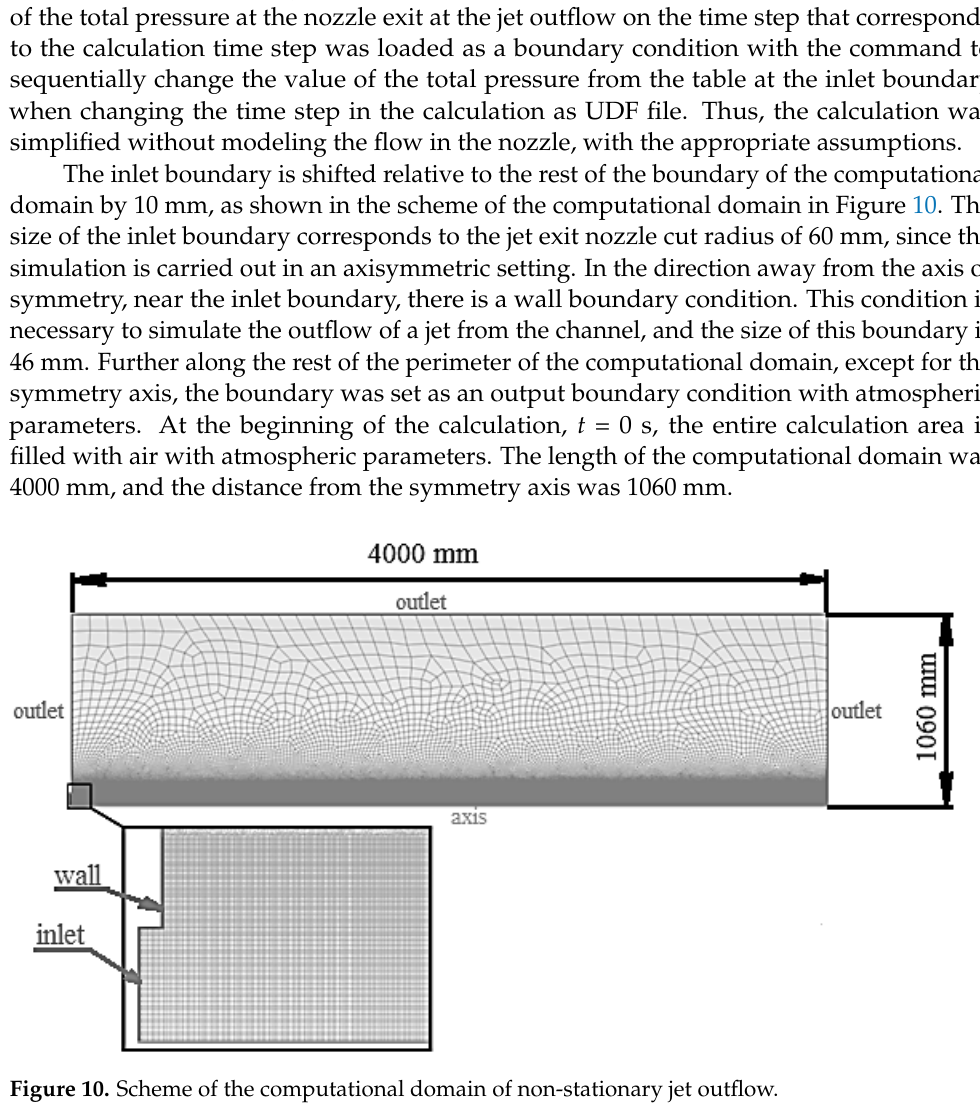
Figure 11. Calculation of the non ‐ stationary jet with Р 0 (0) = 0.70 MPa: ( a ) t = 0.01 s; ( b ) t = 0.02 s. Figure 7 shows that the rate of pressure increase in the non ‐ stationary calculation at different distances from the nozzle exit quite accurately repeats the experimental records, which indicates the correctness of the initial conditions. The calculated graphs obtained for a non ‐ stationary jet, at a different distance from the nozzle exit, lie in the experimental data distribution field and have high coincidence accuracy. As the distance from the noz ‐ zle exit increases, the value of the maximum pressure amplitude decreases, since the jet attenuates. The total calculation time interval was limited to 0.0225 s. Based on the results of non ‐ stationary numerical simulation, it was shown that the simulation technique used makes it possible to simulate the flow of a pulsed jet with high accuracy. 7. Calculation of the Stationary 3D Gas Jet For the parametric analysis of the forces acting on the heat exchange tubes, it is more advisable to consider the flow around them with the stationary steady flow corresponding to the chosen instant of the working mode.